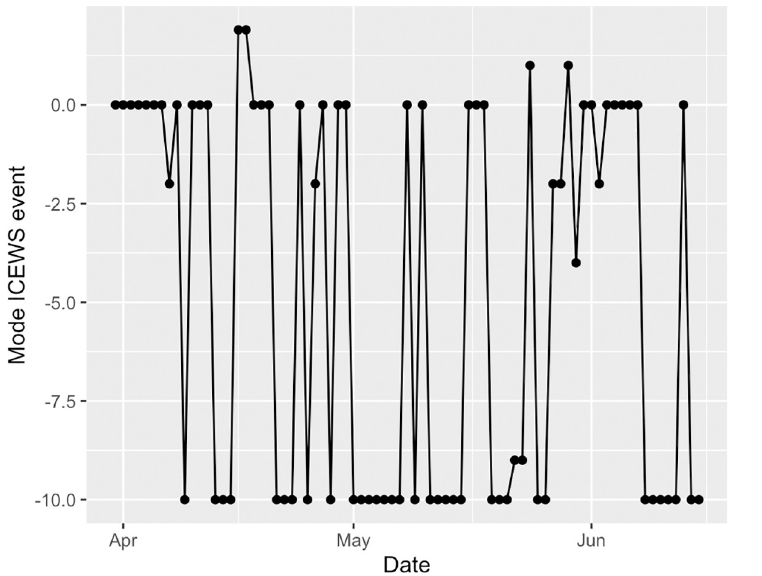
Fig 12. A plot of the most frequently documented ICEWS event score per